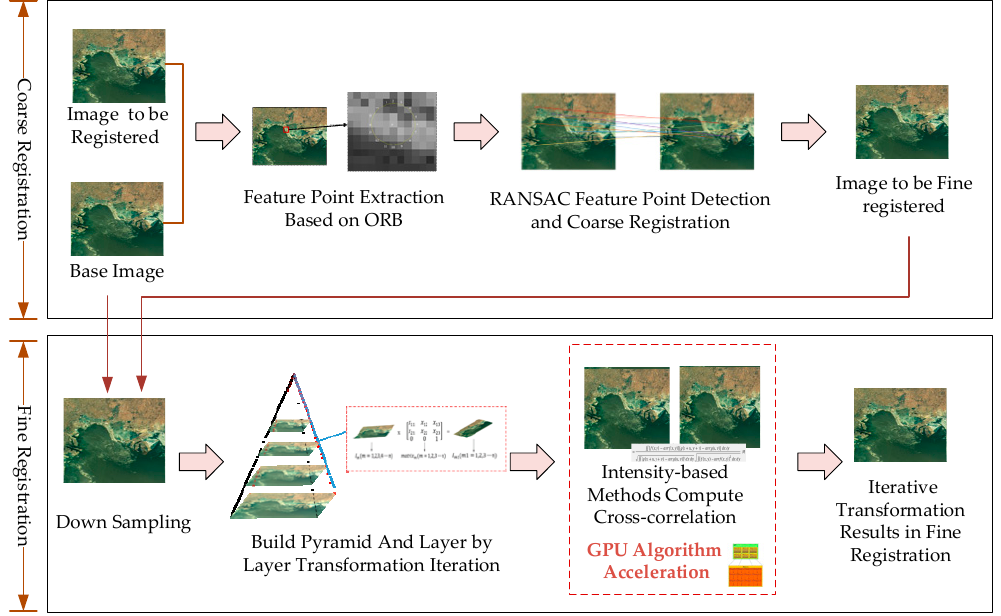
Figure 1. Workflow of the sub-voxel-level high-precision image registration algorithm based on a combination of oriented fast and rotated brief (ORB) feature extraction and an intensity-based registration process. RANSAC: random sample consensus.